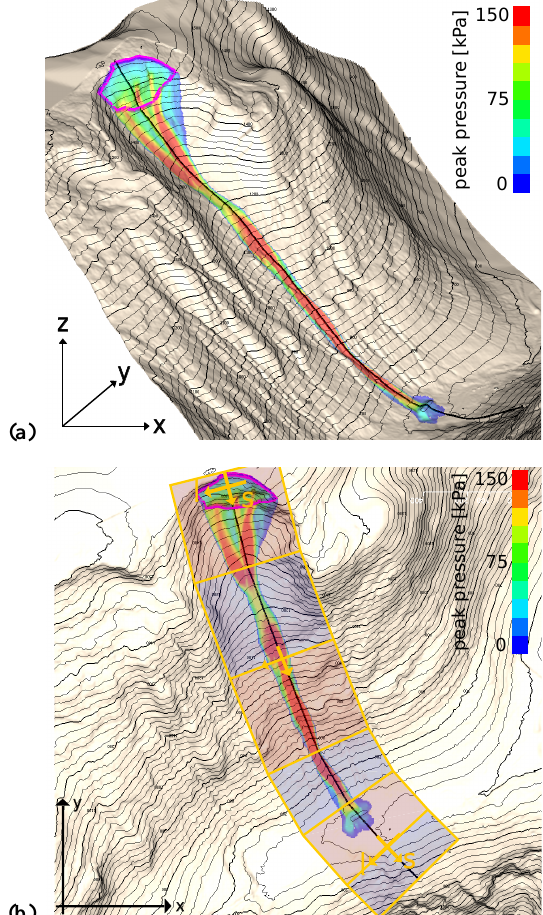
Fig. 2. Avalanche simulation at Ryggfonn, Norway. (a) Three di- mensional view of the topography (100m main contour lines) with the peak pressures field P(x,y) . The central flow line is marked in black, the release area in pink. (b) Avalanche path dependent domain of width w = 500m and coordinate system along the cen- tral flow line. The simulation results given in the global Cartesian coordinate system (x,y) are transformed in an avalanche path de- pendent (s,l) coordinate system, with the longitudinal coordinate s in direction of the main avalanche flow and the lateral coordinate l . Shown is the peak pressure field of an avalanche simulation run at Ryggfonn. Blue and red shadings mark the different path domain segments, the black line marks the central flow line of the avalanche dependent coordinate